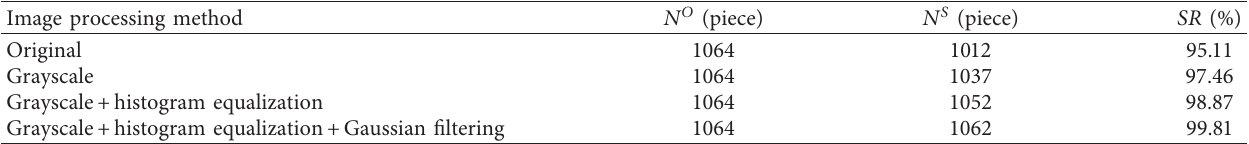
Figure 6: The characteristic interference verification diagram of the bolt subgraph of the Pandrol track fastener. Table 2: Track fastener pictures automatic segmentation results.